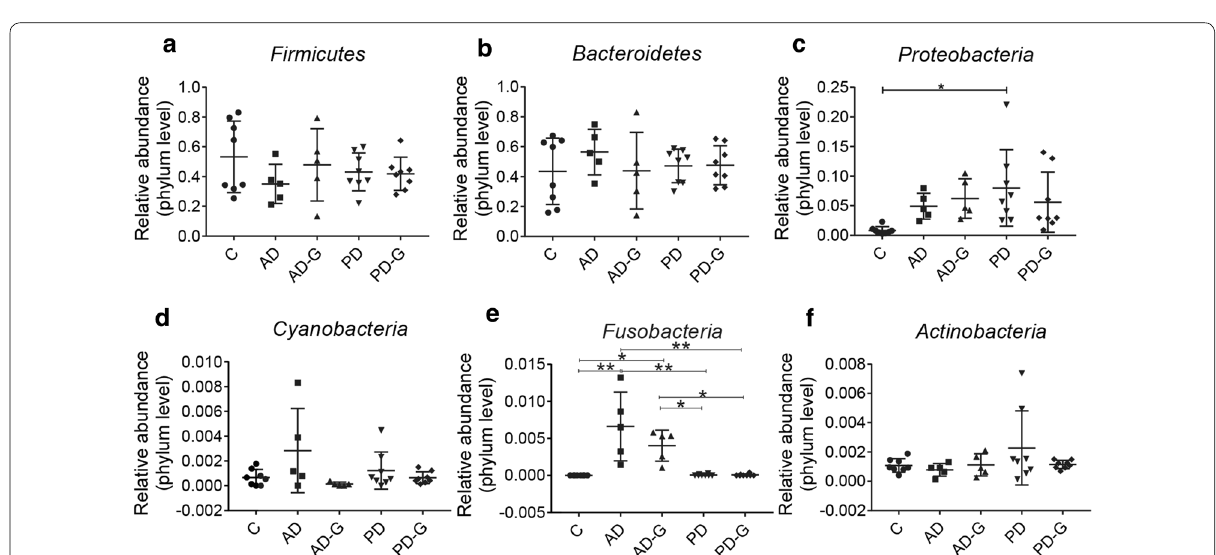
Fig. 5 Effect of the MG1363-pMG36e-GLP-1 on the relative abundance of gut microbial diversity at phylum level in feces of mice. The relative abundance of Firmicutes ( a ), Bacteroidetes ( b ), Proteobacteria ( c ), Cyanobacteria ( d ), Fusobacteria ( e ), Actinobacteria ( f ) in feces of mice.C, control group (n 8); AD, LPS group (n 5); AD-G, LPS 10 9 CFU MG1363-pMG36e-GLP-1 group (n 5); PD, MPTP group (n 8); PD-G, MPTP 10 9 CFU = = + = = + MG1363-pMG36e-GLP-1 group (n 8). Data are presented as mean SD. *p < 0.05, **p < = ±